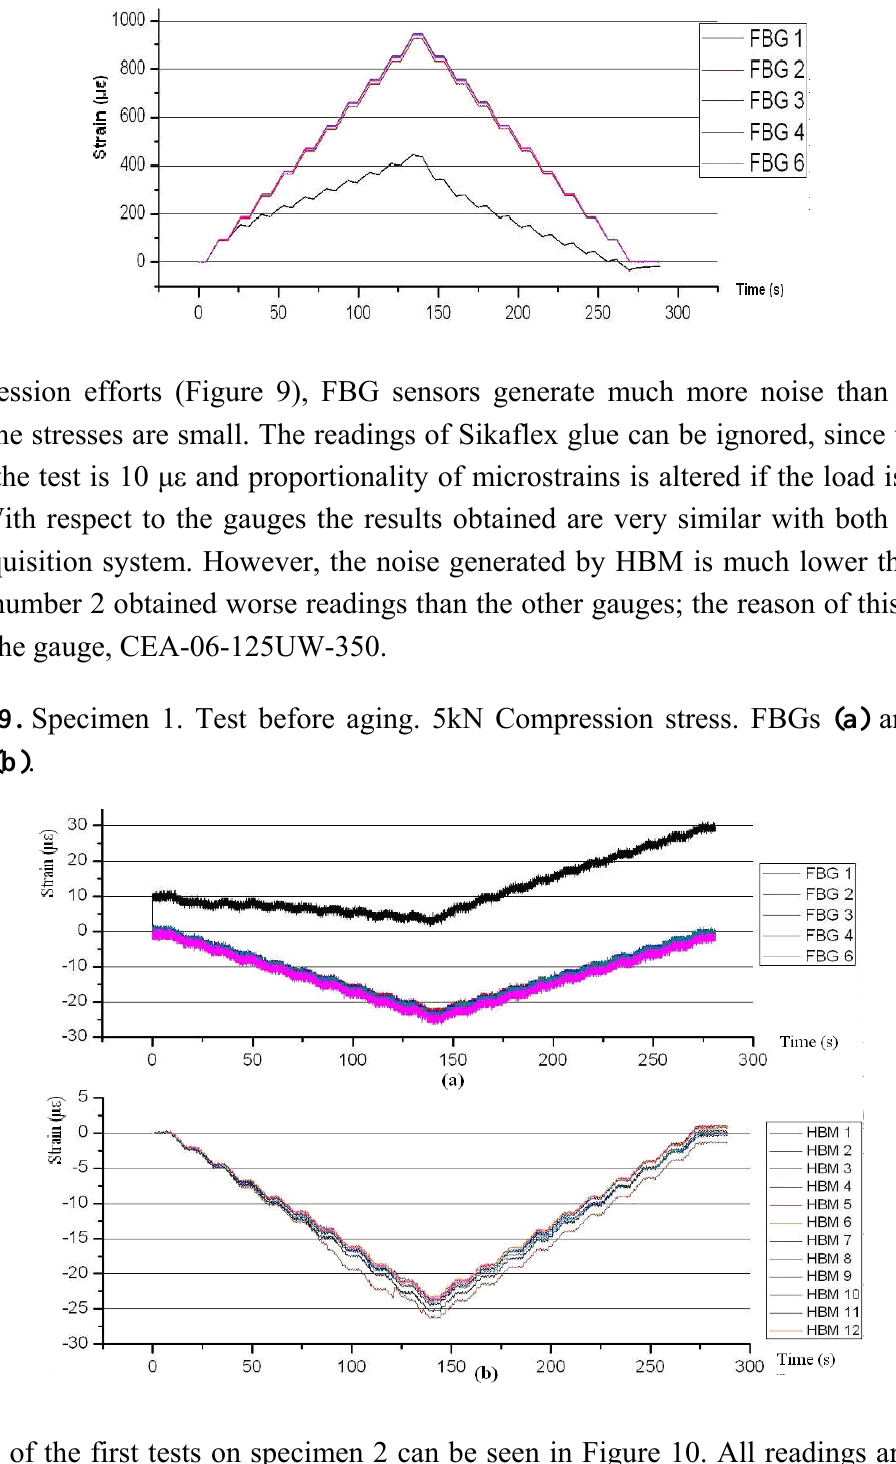
Figure 8. Specimen 1. Test before aging. 200 kN Traction stress. FBGs 1 to 6. Note that FBG5 is used for temperature compensation.